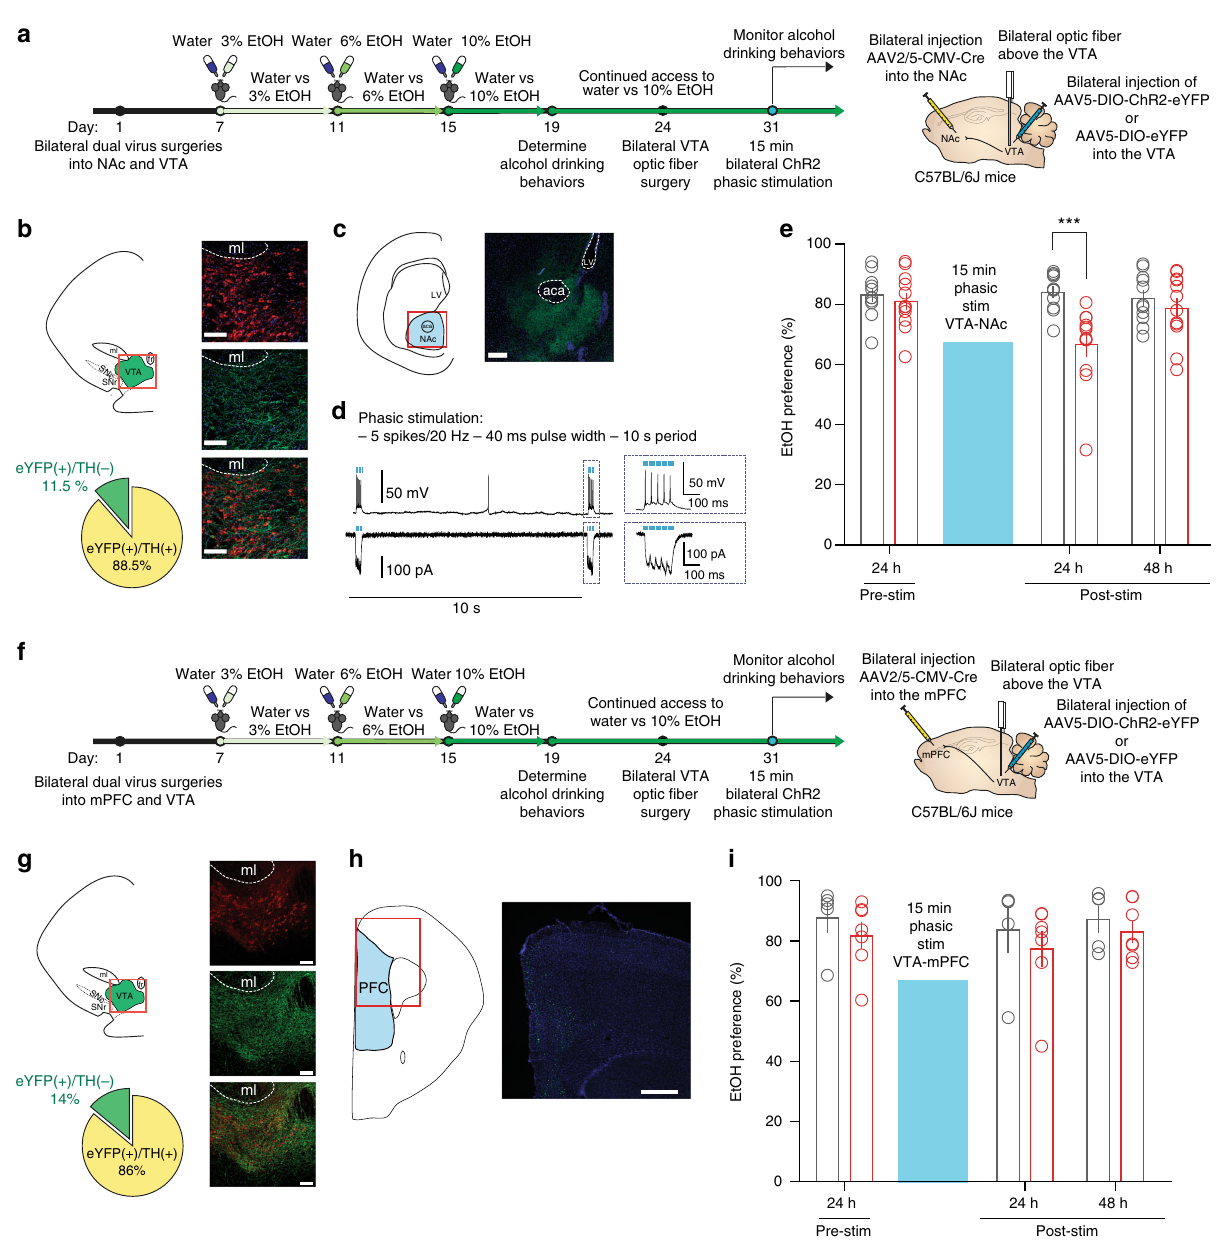
Fig. 5 Phasically activating VTA-NAc neurons reduces high alcohol drinking behaviors. a Timeline of experiments and schematic of surgeries for VTA- NAc experiments. High alcohol drinking C57BL6J mice expressing either AAV5-DIO-eYFP (eYFP, control vector) or AAV5-DIO-ChR2-eYFP (ChR2) in VTA-NAc neurons were selected following the alcohol drinking paradigm to undergo bilateral optic ferrule implantation into the VTA followed by phasic optical stimulation. b VTA colocalization of AAV5-DIO-ChR2-EYFP expressed in VTA neurons projecting to the NAc with TH ( n = 469 cells from 8 mice, scale bar = 100 μ m). c Terminals in the NAc of VTA neurons containing AAV-DIO-ChR2-eYFP terminals from dual viral injections (scale bar = 250 μ m). d Electrophysiological validation of phasic (burst) optical light stimulation via ChR2 in VTA-NAc neurons eliciting (top) action potentials and (bottom) inward currents. e EtOH preference of high alcohol drinking eYFP and ChR2 mice following 15 min of phasic VTA-NAc stimulation (two-way RM ANOVA: interaction effect F (2,42) = 9.822, P < 0.001; drinking group effect F (1,42) = 5.292, P < 0.05; time effect F (2,42) = 6.518, P < 0.01; Bonferroni post hoc test, eYFP vs ChR2 at 24 h *** P < 0.001. n = 11 mice; n = 12 mice). f Timeline of experiments and schematic of surgeries for VTA-mPFC experiments. High alcohol drinking C57BL6J mice expressing either AAV5-DIO-eYFP (eYFP, control vector) or AAV5-DIO-ChR2-eYFP (ChR2) in VTA-mPFC neurons were selected following the alcohol drinking paradigm to undergo bilateral optic ferrule implantation into the VTA followed by phasic optical stimulation. g Colocalization of TH and AAV5-DIO-ChR2-EYFP expressed in VTA neurons projecting to the mPFC in the VTA ( n = 300 cells from 3 mice, scale bar 100 μ m). h Fibers from the VTA AAV-DIO-ChR2-eYFP in the mPFC (scale bar 500 μ m). i EtOH preference behaviors of eYFP and ChR2 high alcohol drinking mice following phasic stimulation of the VTA-mPFC pathway (two-way RM ANOVA: interaction effect F (2,20) = 0.05370, P > 0.05; drinking group effect F (1,20) = 0.7967, P > 0.05; time effect F (2,20) = 1.087, P > 0.0f; Bonferroni post hoc test, P > 0.05. n = 5 mice; n = 7 mice). Data represented as mean +